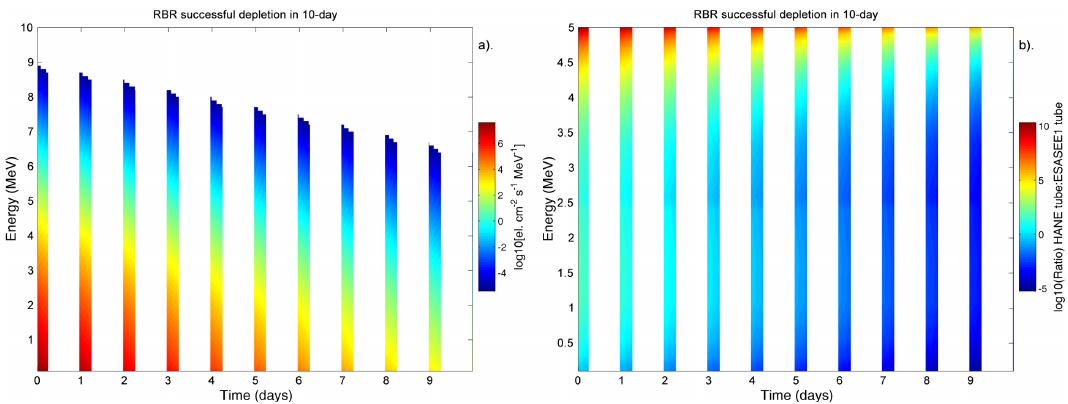
Fig. 9. The changing HANE-injected differential flux at L =1.57 during the operation of an assumed ground based RBR-system, in the same format as Fig.